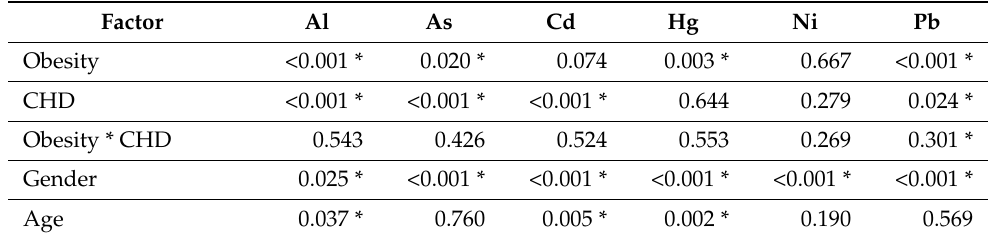
Table 3. Factorial analysis of the association between the presence of obesity, coronary heart disease, and their interaction with hair toxic metal content adjusted for age and gender.